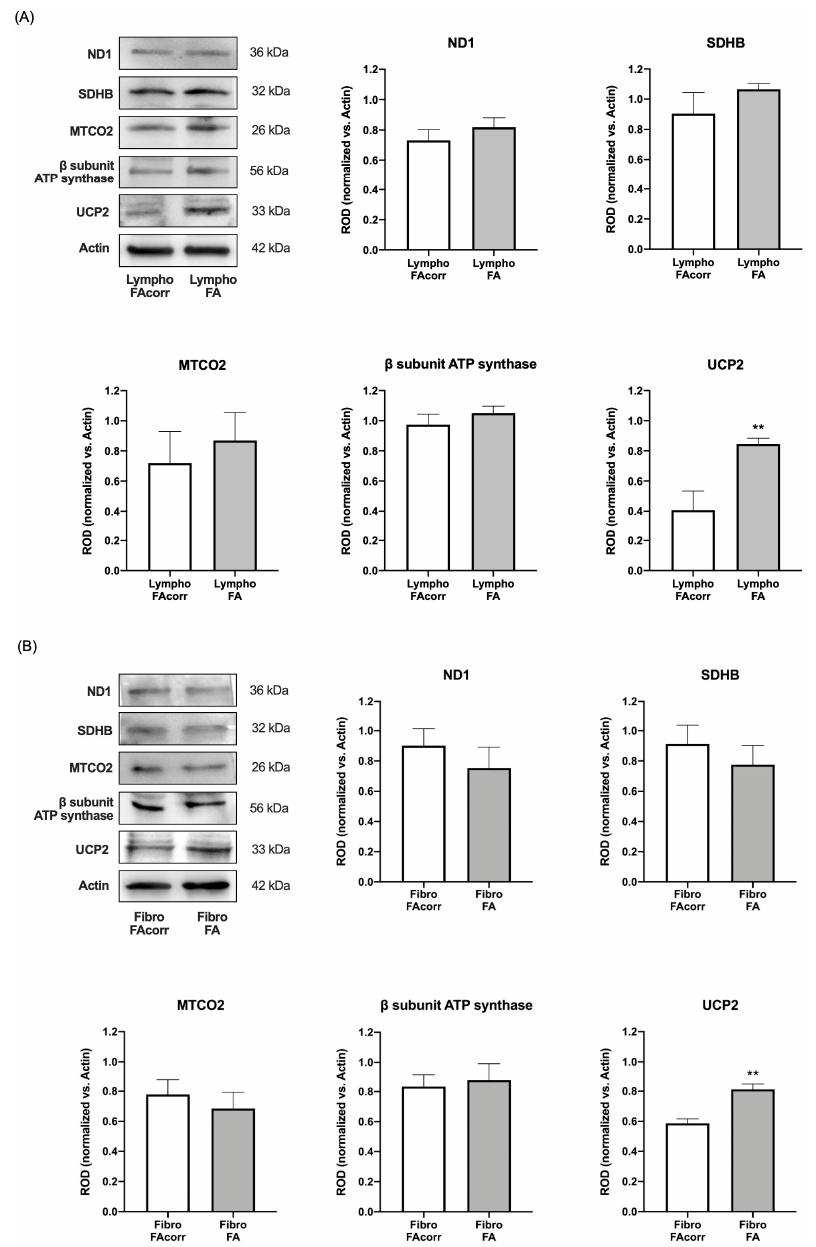
Figure 3. OxPhos subunits and UCP2 expression in lymphoblasts and fibroblasts mutated for the FANC-A gene. Western blot (WB) signals of OxPhos subunits expression in lymphoblast ( A ) and fibroblast ( B ) cell lines with and without FANC-A mutation. Protein expression levels are normalized on the housekeeping signal (Actin) revealed on the same membrane: ND1 (Complex I), SDHB (Complex II), MTCO2 (Complex III), and ATP synthase β subunit; WB signal of uncoupling protein 2 (UCP2) expression. Data in histograms are reported as mean ± SD, and each panel is